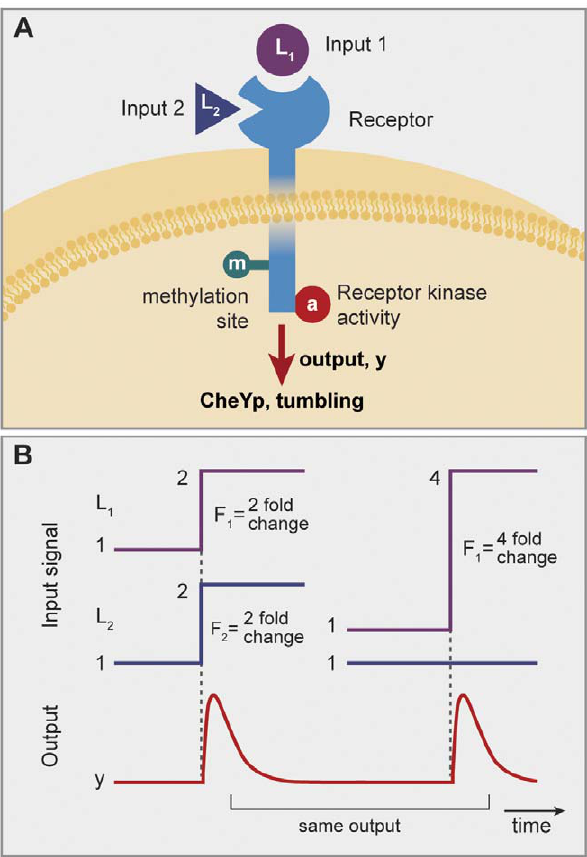
Figure 2. Product-rule integration of two input signals in an FCD system, where both inputs bind the same receptor with the same number of sites. (A) Example of a receptor that binds to input ligands, the Tar receptor that binds both MeAsp, and maltose. (B) Response to simultaneous steps of L 1 and L 2 of folds F 1 and F 2 is dependent only on F 1 F 2 . Thus, steps with F 1 =4 and F 2 =1 shows the same output dynamics as two steps with F 1 =2 and F 2 =2, since in both cases F 1 F 2 =4. This holds as long as all concentrations are not too high or too low, that is - only in the FCD concentration range.